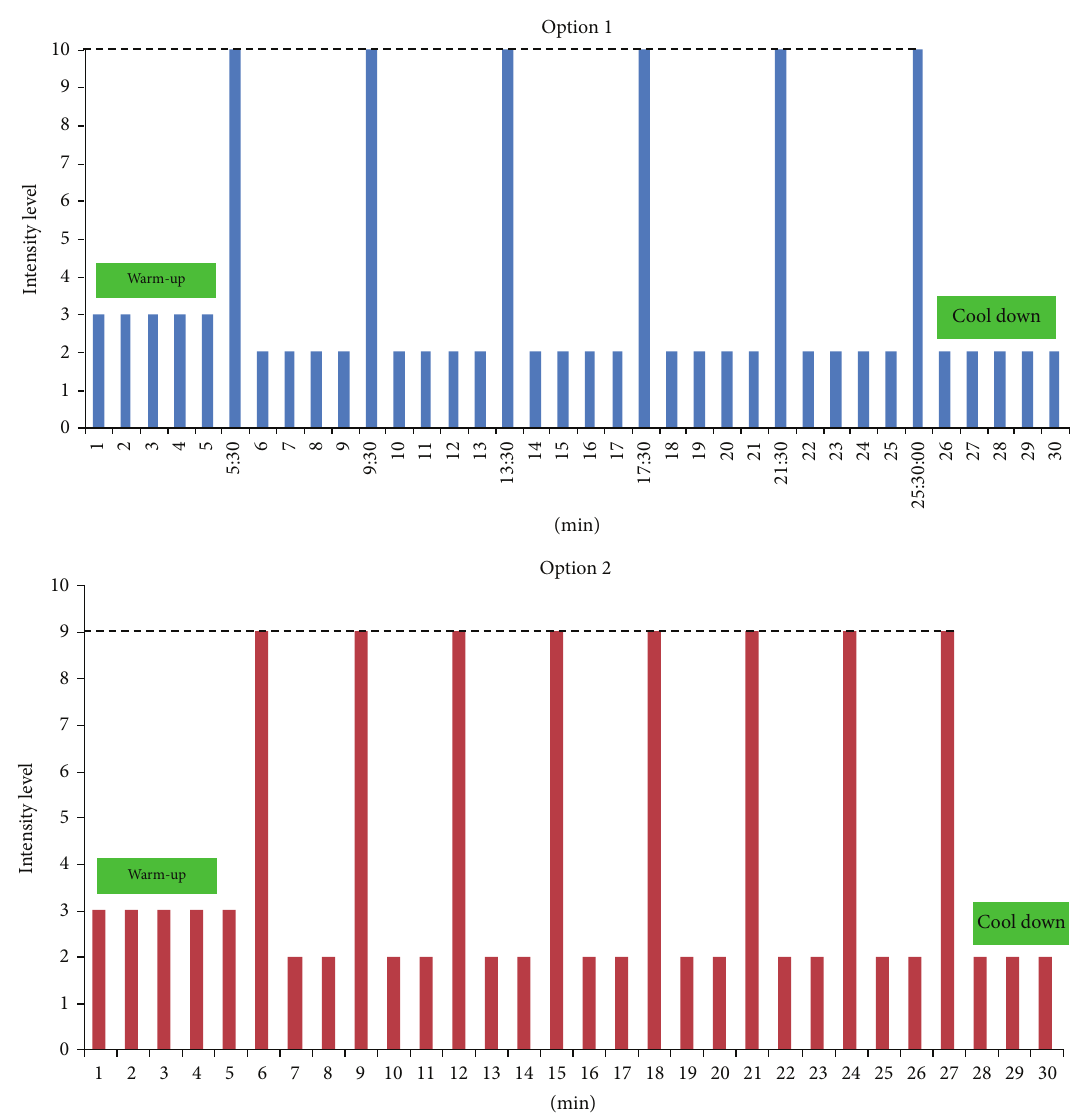
Figure 1: Interval exercise (I). Choose an exercise (walking, jogging, running, cycling, swimming, elliptical, snowshoeing, cross-country skiing, jumping rope, rollerblading, rowing, etc.) and one of two options. Option 1: perform 5–7 “all-out” sprint Intervals for 30-seconds at intensity level 10 followed by a 4 minute recovery at intensity Level 2; or Option 2: perform 8–12 sprint “almost all-out” intervals for 60 seconds at intensity level 9 followed by a 2-minute recovery at intensity Level 2. At the beginning and end of each interval session perform a 5-minute dynamic warm-up and gentle stretching cool down, respectively, so that each session is completed within 30–40